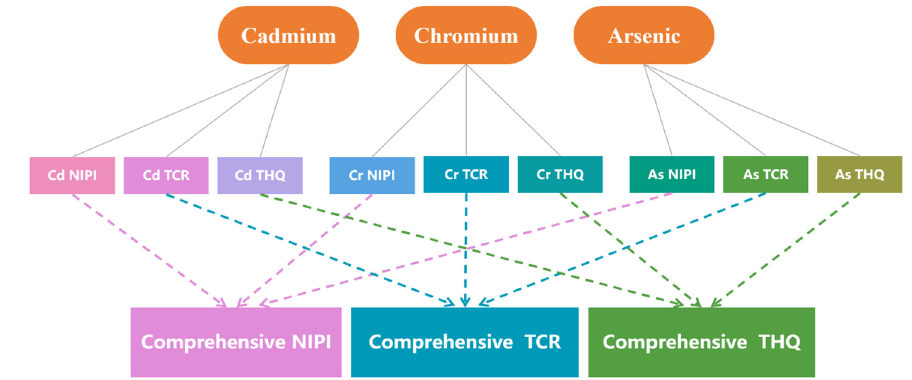
Figure 3. Calculation of the risk assessment index using the AHP-EW.